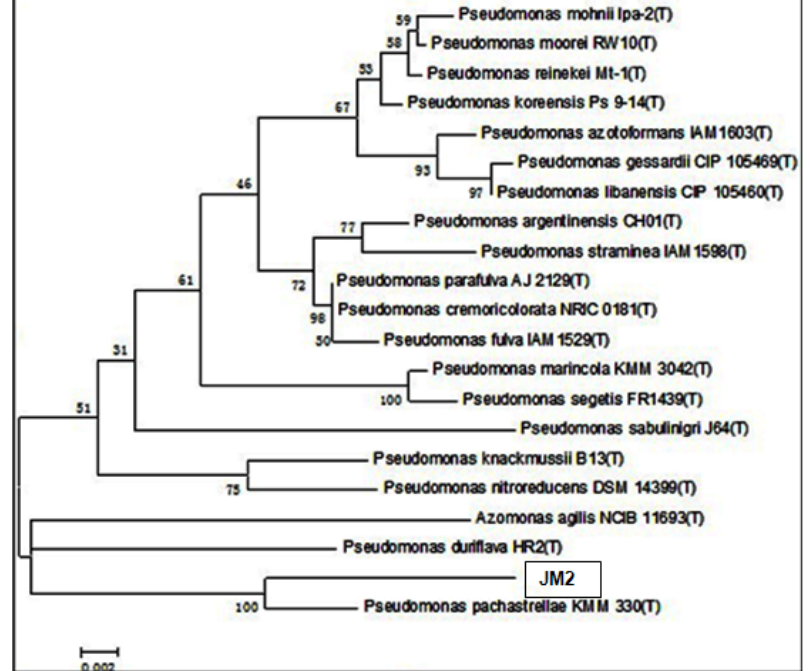
Figure 5. Phylogeny of strain JM2. Phylogenetic maximum-parsimony tree calculated using partial 16S rDNA gene sequences. Maximum-parsimony (1000